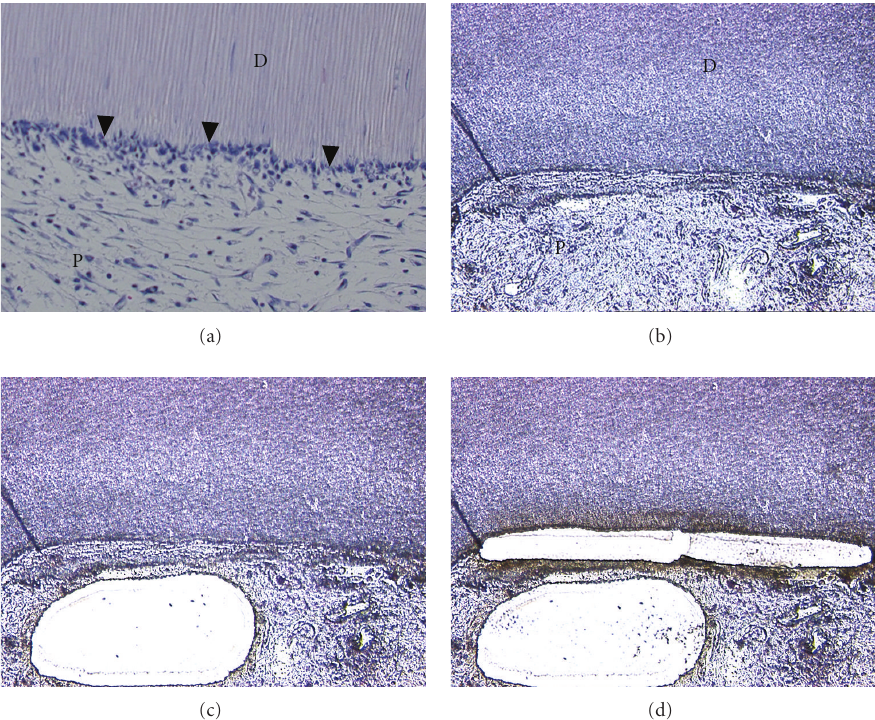
Figure 3: Step-by-step characterization of the technique based on LCM used for retrieval of either the odontoblastic layer or the tissue underneath the odontoblastic layer from formaldehyde-fixated para ffi n embedded tissue sections that had been demineralized. (a) H&E staining of the engineered dental pulp-like tissue after 21 days of implantation. D: dentin. P: engineered dental pulp. Arrowheads: odontoblastic layer. (b) Air dried slide of the engineered dental pulp-like tissue. D: dentin. P: engineered dental pulp. (c) Removal of the tissue underneath the odontoblastic layer. (d) Retrieval of the odontoblastic